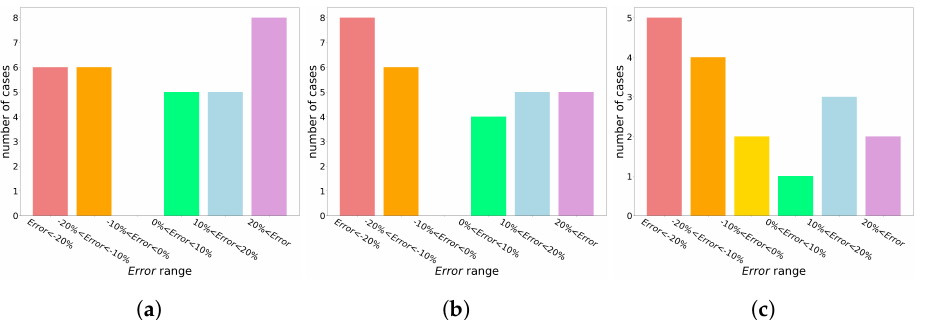
Figure 22. Number of cases in each Error percentage interval for the basic scheme ( a ) with ZOOMIB assumptions and ( b ) with COOMIB assumptions